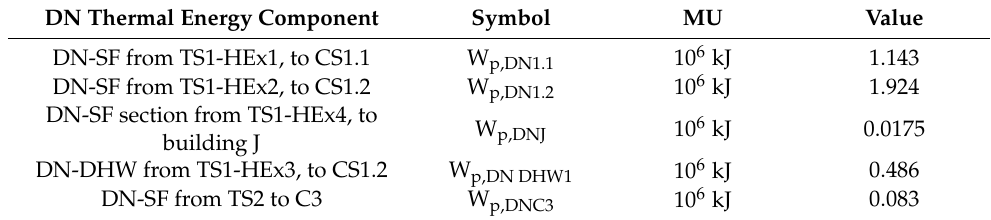
Table 10. Average hourly values of DN energy losses, period 20–22 January 2020.